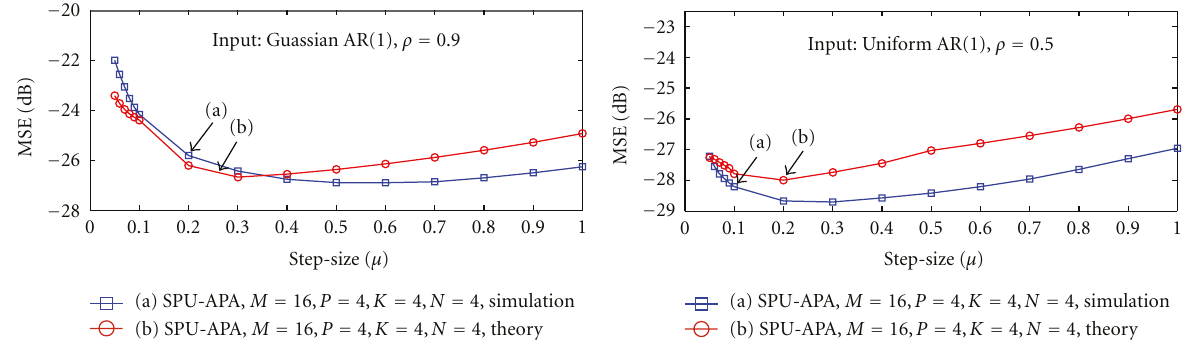
Figure 19: Steady-state MSE of SPU-APA with M = 16, P = 4, K = 4, and N = 4 as a function of the step size in nonstationary environment for di ff erent input